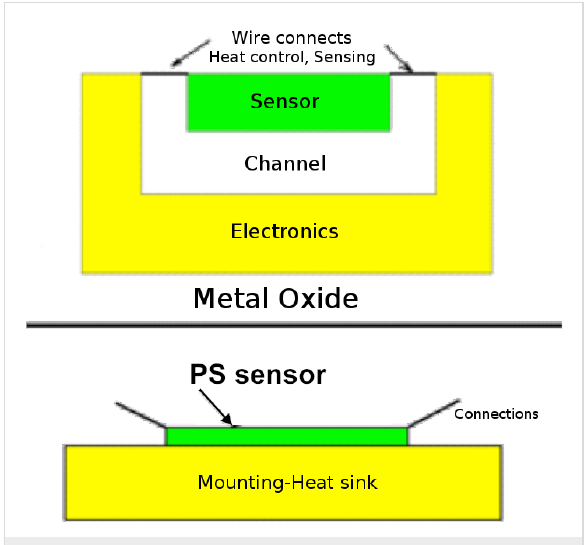
Figure 9: Comparison of a metal-oxide (usually SnO 2 or WO 3 ) elevated-temperature (150–500 °C) heat-controlled sensor separated from its electronics by a channel, with a heat- sunk PS sensor oper- ating at room temperature and capable of operation to temperatures of at least 80